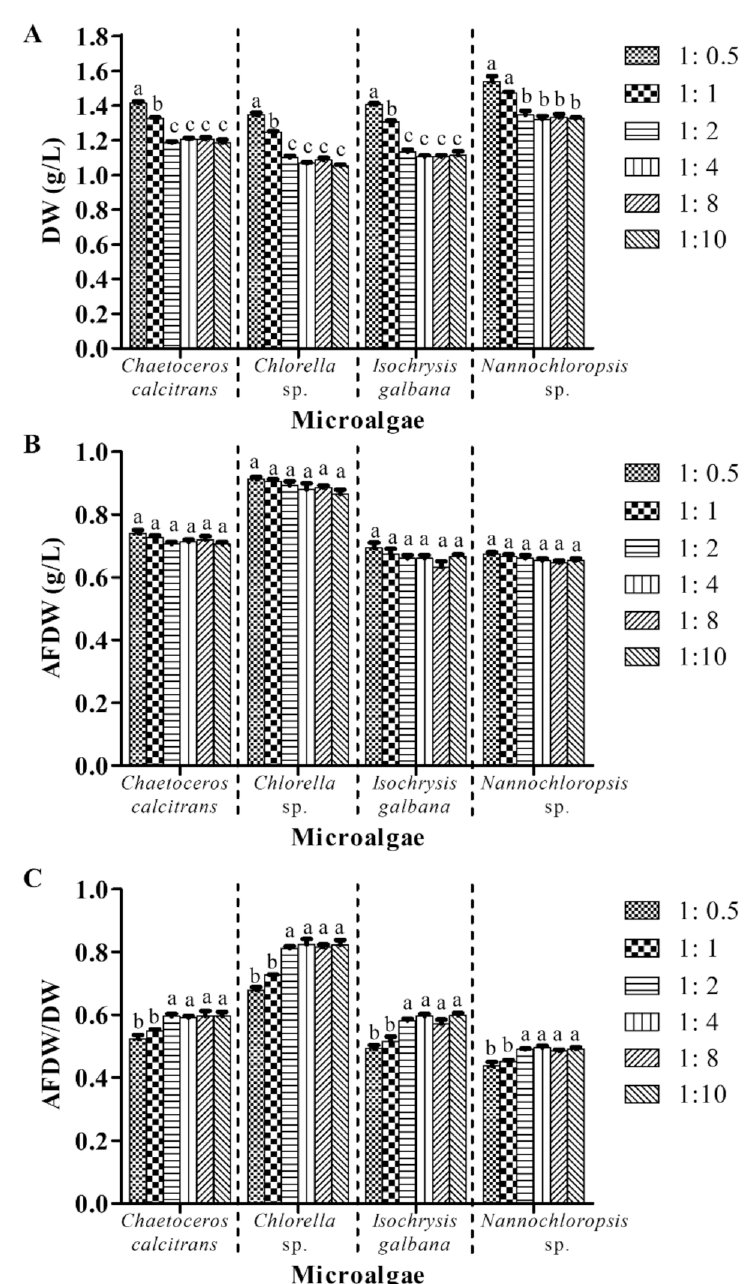
Figure 6. Biomass of four different marine microalgae subjected to different culture: washing agent ratios (v:v). ( A ) dry weight ( B ) ash-free dry weight ( C ) ash-free dry weight/dry weight. The other parameters were unchanged (with washing process; GF/A; pretreatment of GMF at 450 ◦ C for 2 h; 0.05 M ammonium formate; one washing cycle). Different letters for the respective microalgae indicate statistically significant differences ( p < 0.05) in terms of biomass among different culture: washing agent ratios (v:v). DW, dry weight; AFDW, ash-free dry weight. Data are expressed as mean ± standard error (n =